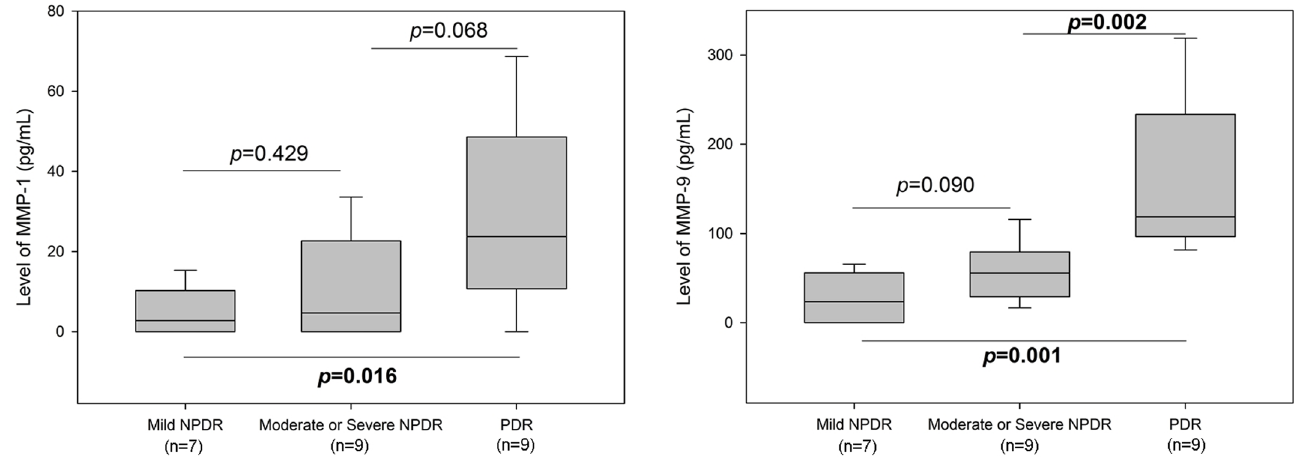
Fig 2. The concentrations of metalloproteinase (MMP)-1and MMP-9 by the stage of diabetic retinopathy differed significantly among groups. Post hoc analysis showed a significant difference in MMP-1 concentrations between the mild NPDR (non-proliferative diabetic retinopathy) group and the PDR (proliferative diabetic retinopathy) group. MMP-9 concentrations differed significantly between the mild NPDR group and the PDR group; and between the moderate or severe NPDR group and the PDR group.